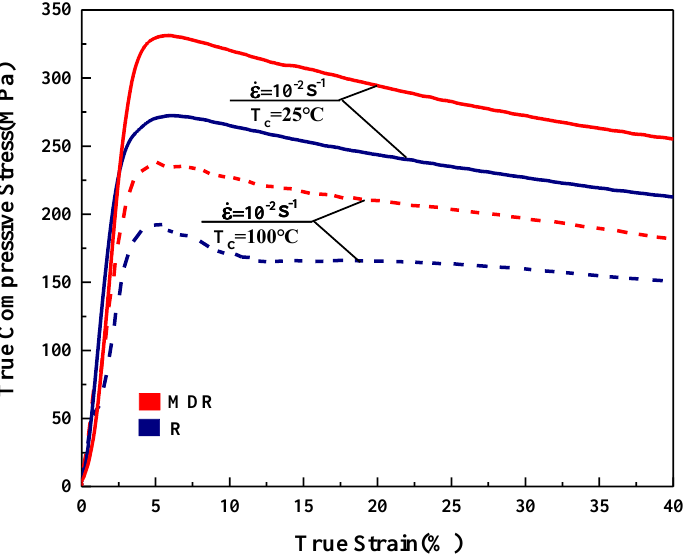
Figure 8. Compressive true stress − true strain curves of cryogenic rolled alloys.